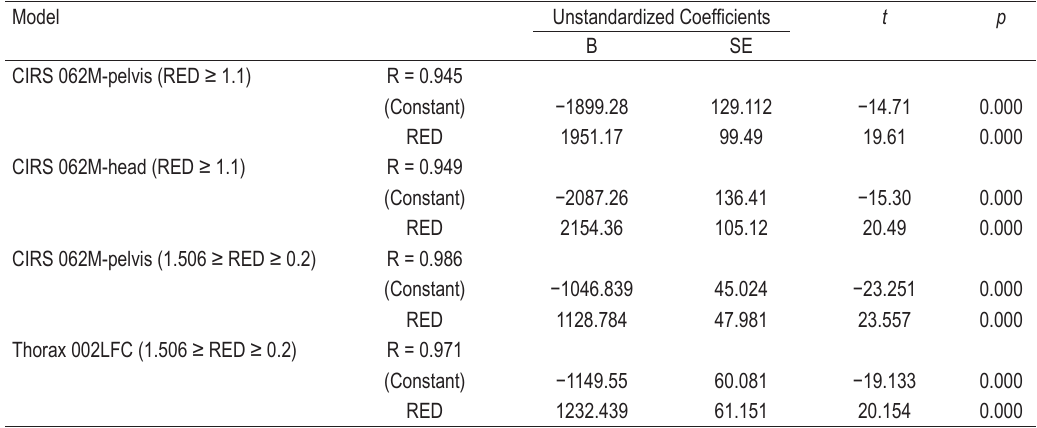
TABLE 4. Linear regression models for CIRS 062M-pelvis and head, based only on cases for RED ≥ 1.1 and CIRS 062M-pelvis and Thorax 002LFC phantom based on cases for 1.506 ≥ RED ≥ 0.2